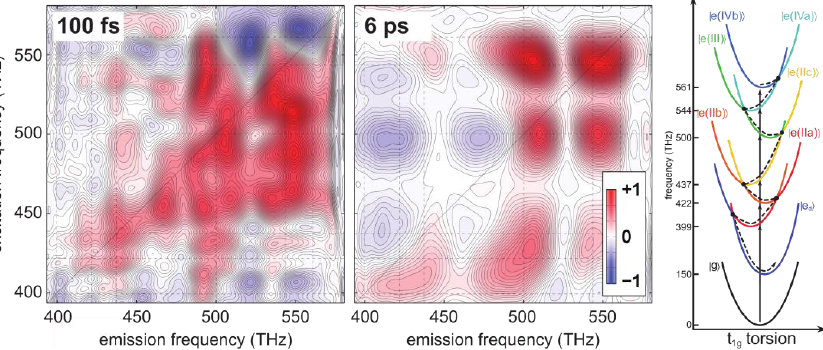
Fig. 1. The 2D electronic spectra of [IrBr 6 ] 2- at waiting times of 100 fs and 6 ps (left). A comparison reveals the rapid loss of ESA signal at high excitation frequencies concurrent with the conversion of stimulated emission signal into ESA signal in the 390 – 460 THz